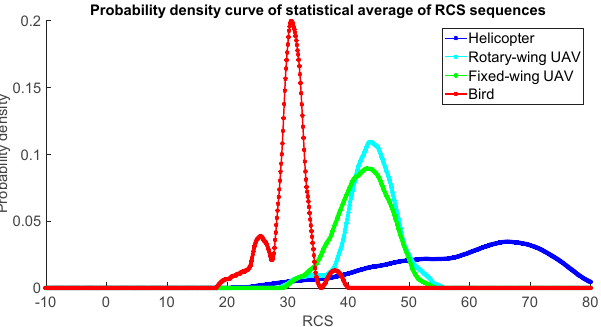
Figure 10. Probability density curves of statistical averages of RCS sequences of helicopters, fixed-wing and rotary-wing UAVs and birds based on measured data.